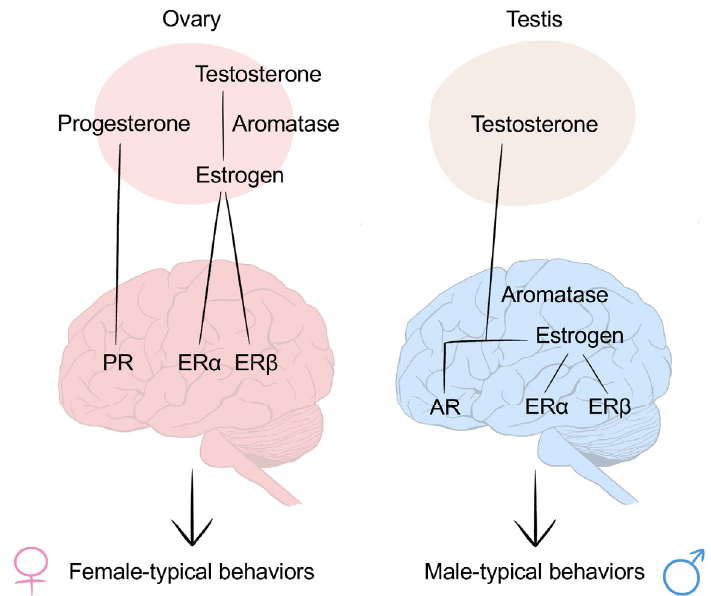
Figure 2. Sexual differentiation in the brain. The organizational–activational hypothesis is the classic review of sexual differentiation of the brain. The brain is organized by sex hormones secreted by the gonads. In females, the absence of the testes keeps the brain from being exposed to a high level of testosterone so that the brain will not be masculinized. Later, at the onset of puberty, the ovaries start to produce female sex hormones, including progesterone and estrogen, which bind to progesterone receptors and estrogen receptors (ER α and ER β ), respectively, and activate the brain to promote female-typical behaviors. In males, during the late gestation and early postnatal period, testosterone that is secreted by the testes binds not only directly to androgen receptors as testosterone, but also to ER α and ER β after it is aromatized into estrogen, so as to masculinize and defeminize the brain. Once puberty begins, the masculinized brain is activated to promote male-typical behaviors.